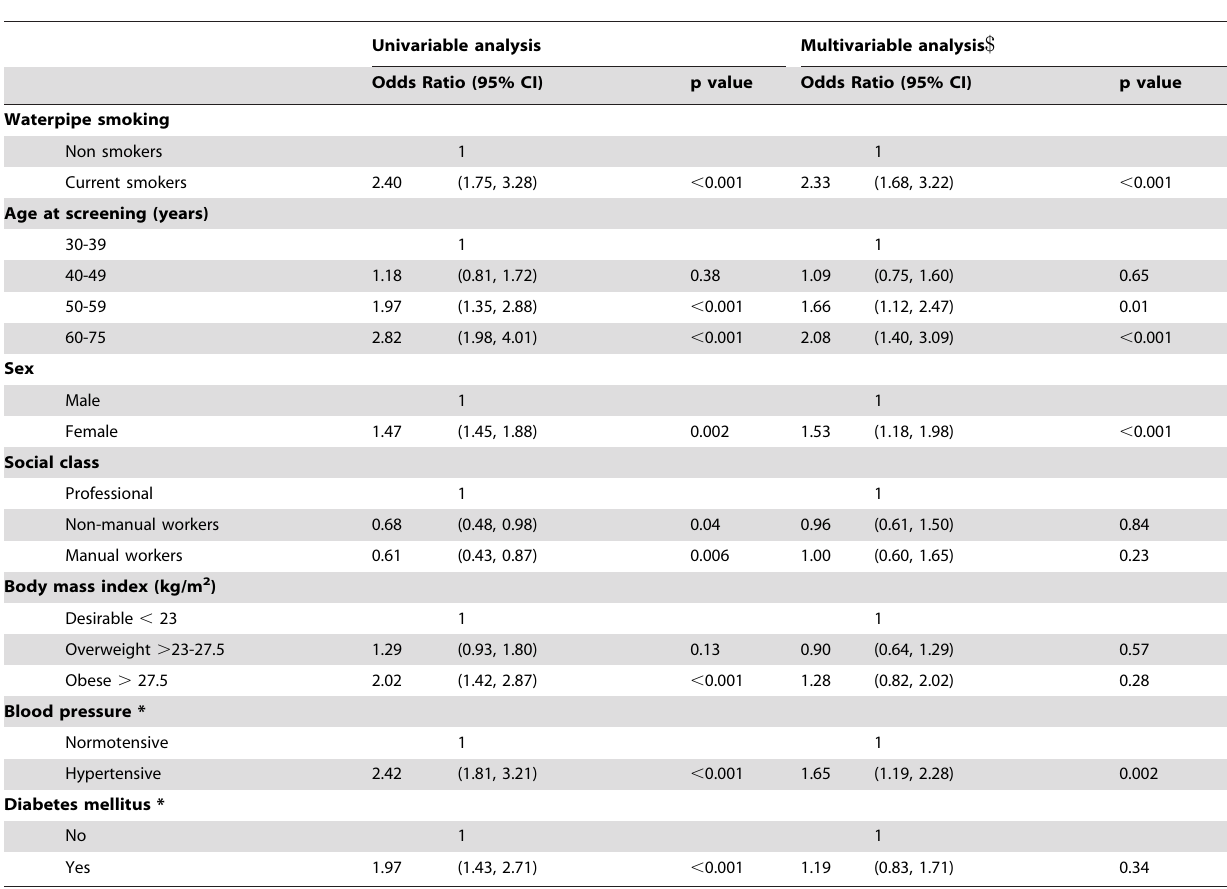
Table 2. Relationship between water-pipe smoking and high-normal albumin